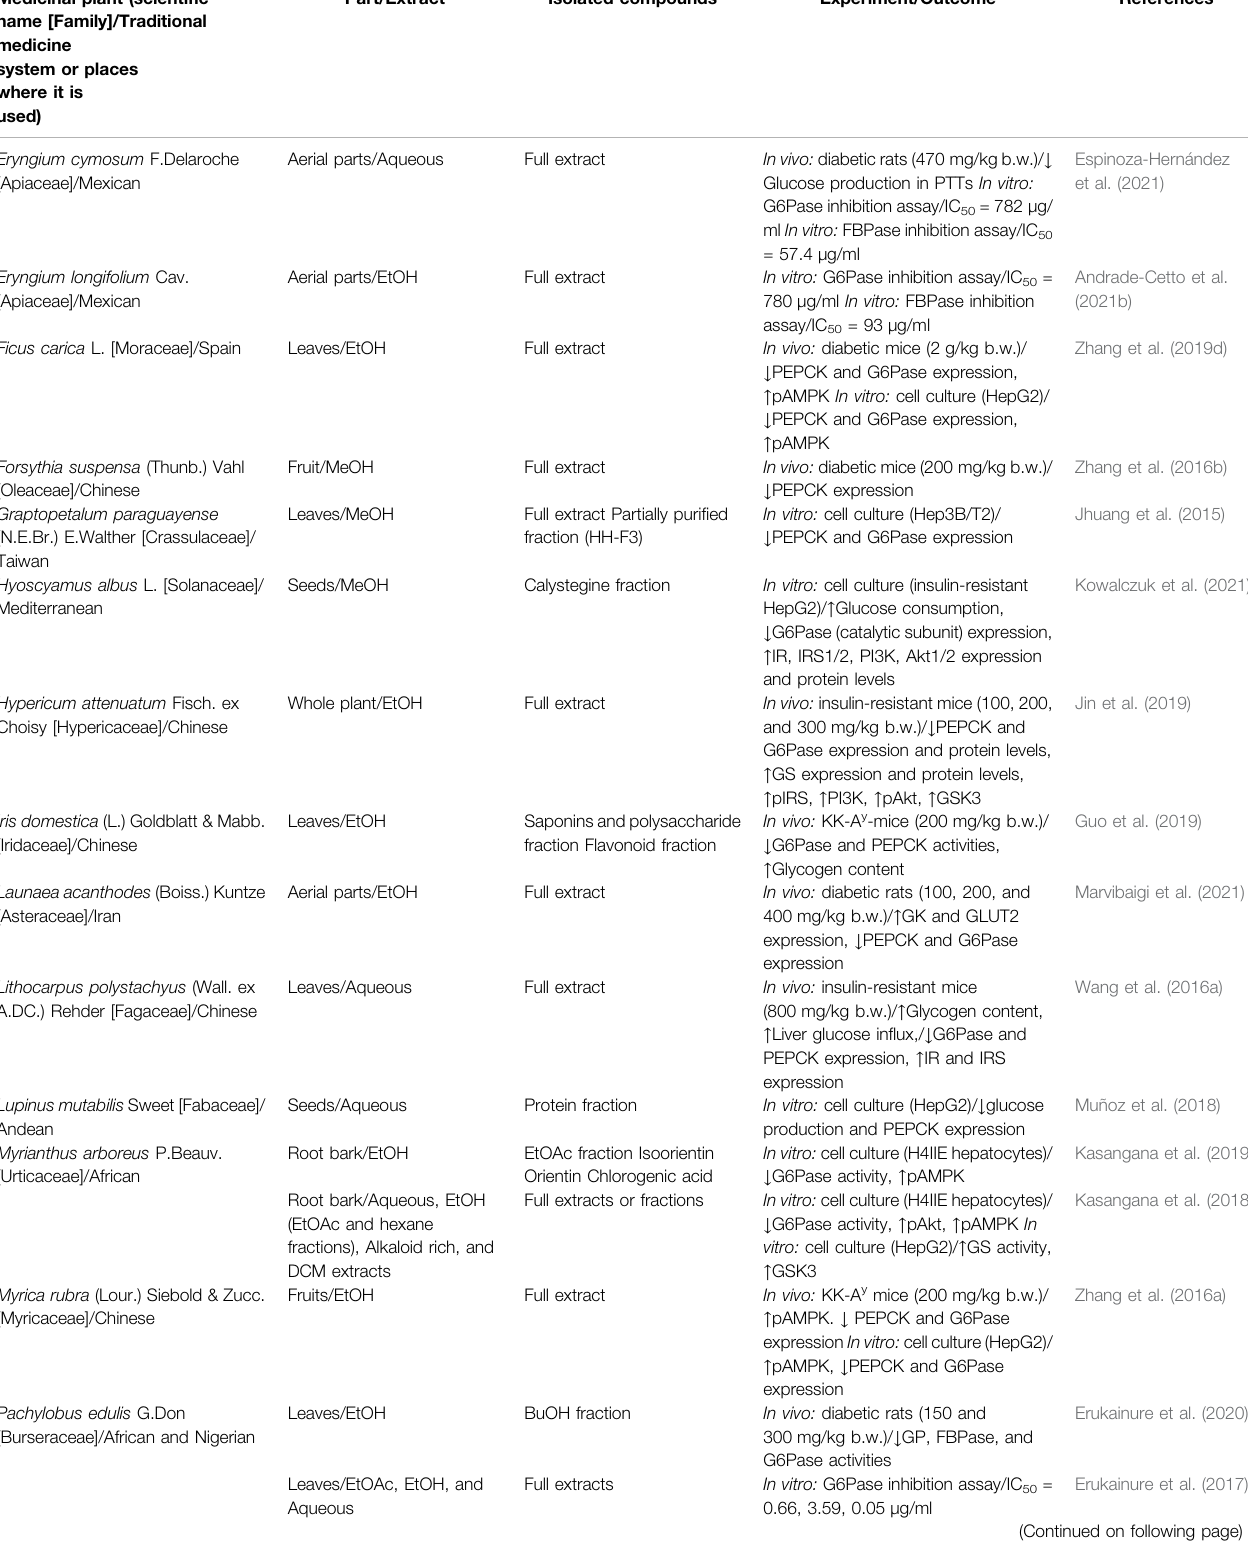
Medicinal plant (scienti fi c name